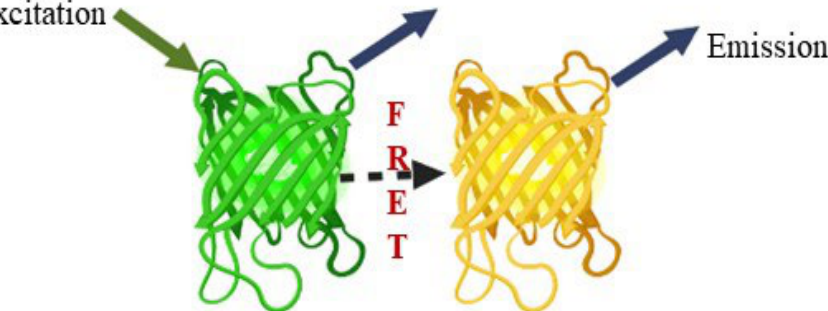
Figure 10. FRET phenomenon, a potential tool.